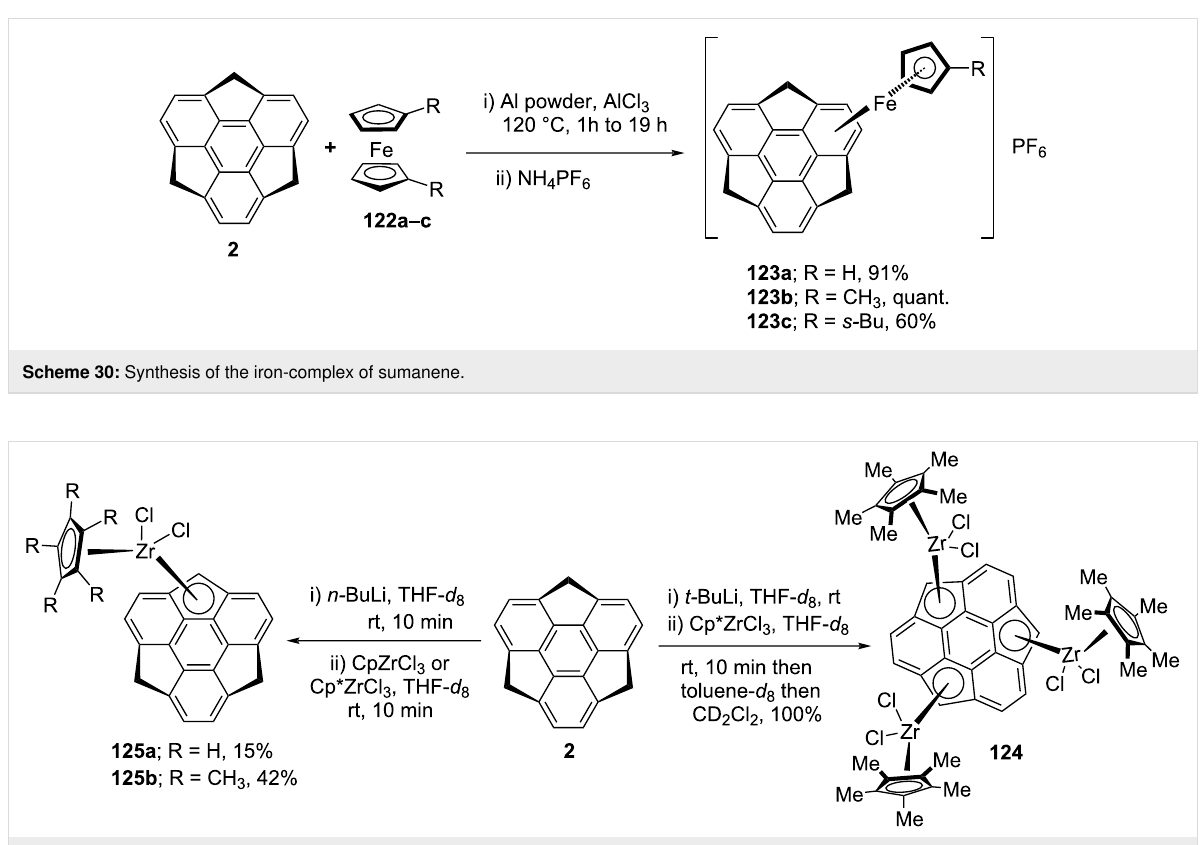
Scheme 31: Synthesis of tri- and mononuclear sumanenyl zirconocene